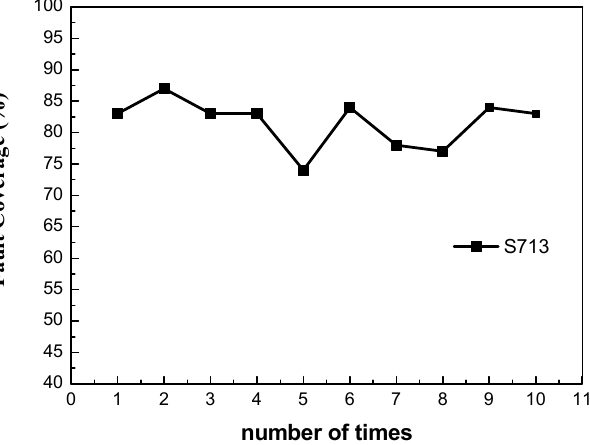
Figure 6. Results of multiple tests against the disturbance algorithm using S713.